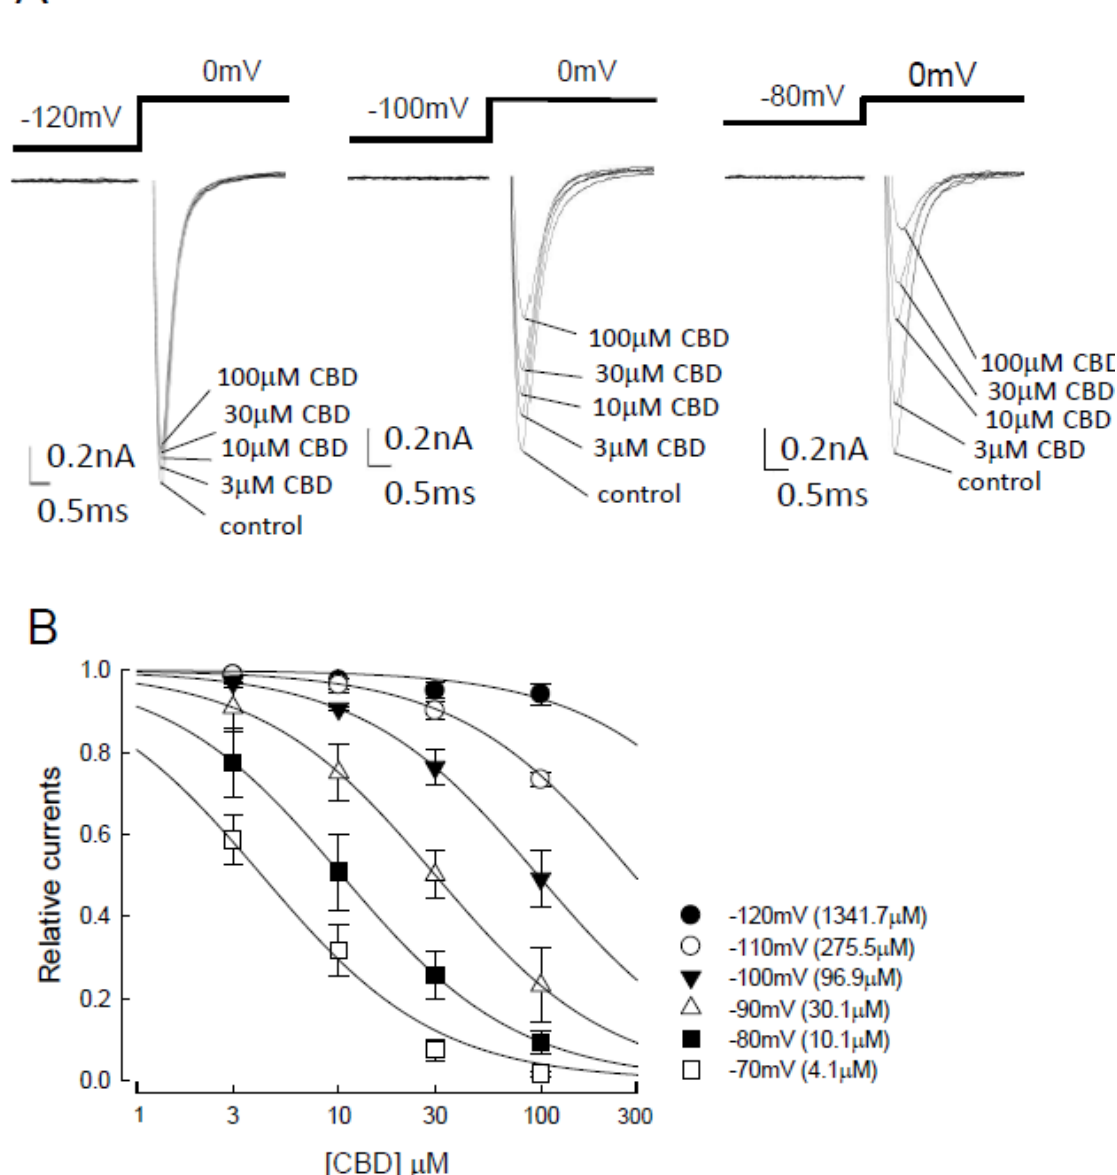
Figure 1. Inhibition of the activation of Na v 1.4 sodium channel by cannabidiol at different holding potentials. ( A ) Current traces of the patched cells expressing Na v 1.4 channels were recorded under treatment with different concentrations (0, 3, 10, 30, and 100 µ M) of cannabidiol (CBD). The cells were held at − 120, − 100, and − 80 mV, followed by depolarization to 0 mV for 5 ms. ( B ) Dose–response curves for inhibition of Na v 1.4 sodium currents by CBD at different holding voltages between − 120 and − 70 mV (n = 5 for a low to high concentration of CBD). Peak currents in the presence of CBD were normalized to control peak currents at each of the different holding potentials and plotted against the CBD concentration. Lines are the fits of data using the following formula: relative current = 1/[1 + ([CBD]/K app )], where [CBD] was the CBD concentrations and K app values were 1341.7, 275.5, 96.9, 30.1, 10.1, and 4.1 µ M at the holding potentials of − 120, − 110, − 100, − 90, − 80, and − 70 mV,